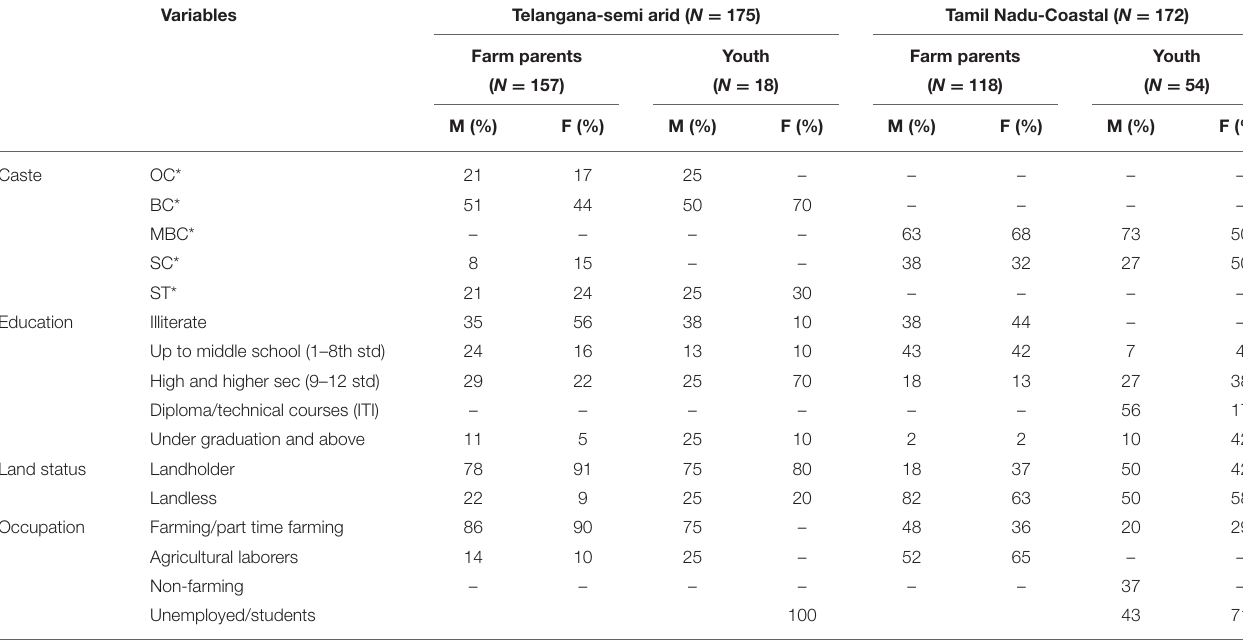
TABLE 3 | Socio demography of Telangana and Tamil Nadu